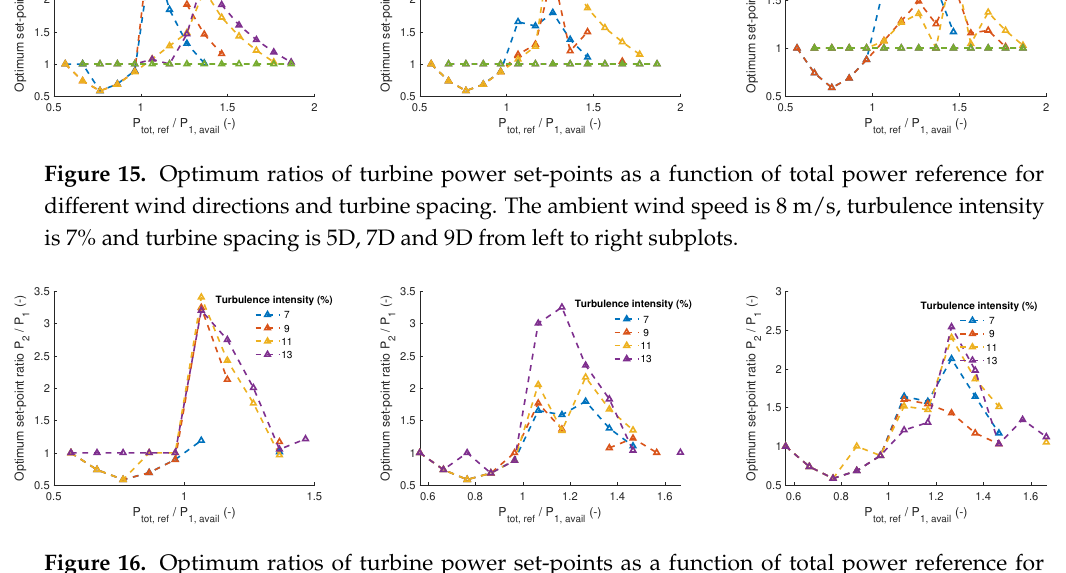
Figure 16. Optimum ratios of turbine power set-points as a function of total power reference for different turbulence intensity (TI) and turbine spacing. The ambient wind speed is 8 m/s, wind direction is 0 degrees and turbine spacing is 5D, 7D and 9D from left to right